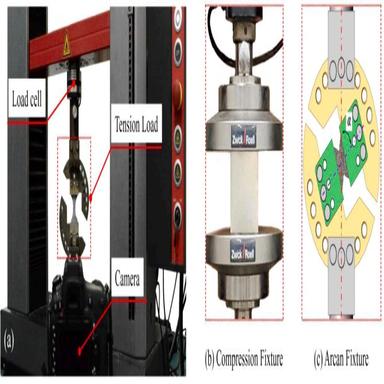
Experimental set-up and the loading fixtures applied in the present tests: (a) Test equipment for PMI foam material; (b) Compression fixture; (c) Arcan fixture for tension, combined tension-shear and compression-shear tests.